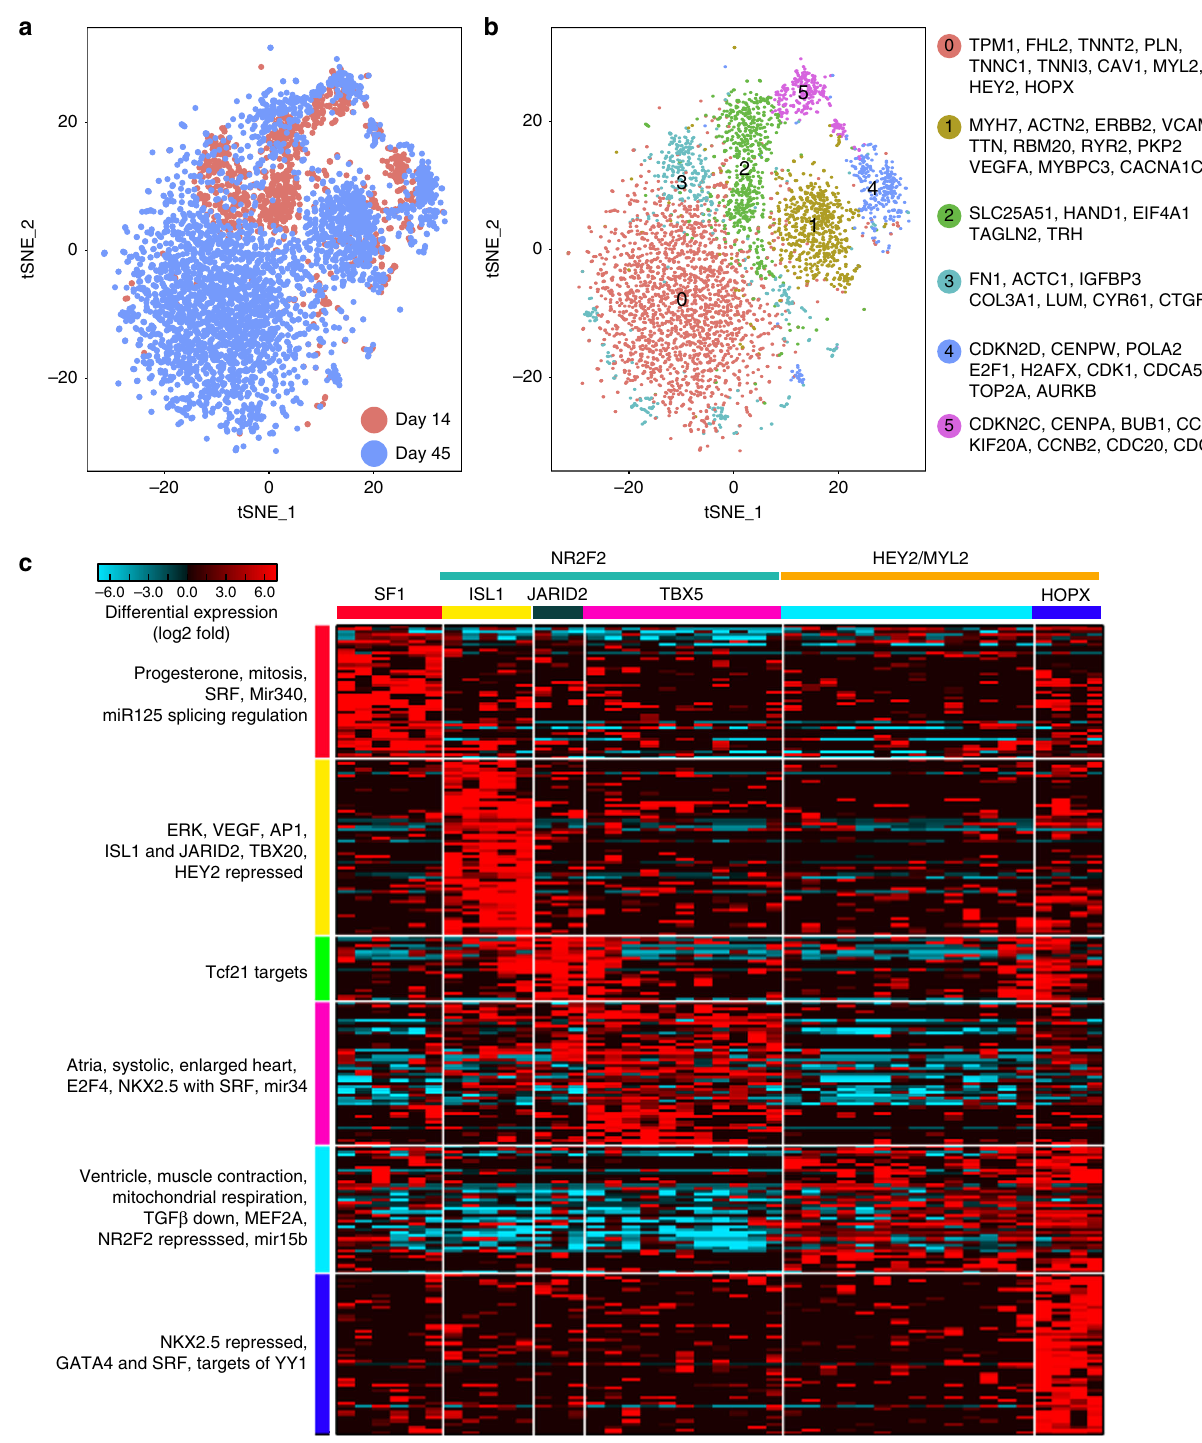
Fig. 2 Single-cell RNA-seq identi fi ed subpopulations of cardiomyocytes. a Late stage cardiomyocytes (4,689 cells with TNNT2 and ACTC1 expression from day 14 and day 45) were further resolved using ICGS to identify subpopulations of cardiomyocytes. Associated t-SNE cell populations were colored by day of differentiation, as well as by cluster identi fi ed (markers within each cluster beside each cluster). b Six cardiomyocyte populations were identi fi ed representing subpopulations of cardiomyocytes in early proliferative stages (Cluster 4, 5) expressing cyclins, mid-cardiomyocyte stage (Cluster 2, 3) expressing HAND1 , and more mature cardiomyocytes (Cluster 0, 1) expressing sarcomeric ( MYH6, MYL2, TNNT2, MYBPC3 ) and calcium handling genes ( RYR2, PLN ). c Single cells from day 30 of differentiation were pro fi led using an independent technology (Fluidigm C1) to resolve coincident mid-to-late state differentiation heterogeneity. Genes associated with distinct observed cell populations identi fi ed by the algorithm MarkerFinder are shown. Factors with de fi ning expression in each of the HOPACH clustered populations are shown ( SF1, ISL1, JARID2, TBX5, MYL2/HEY2 , and HOPX) . Two major groups in hiPSC-CMs were observed to express either NR2F2 or MYL2/HEY2 . Within each group, identi fi ed heart developmental regulators were identi fi ed using the software GO-Elite (left